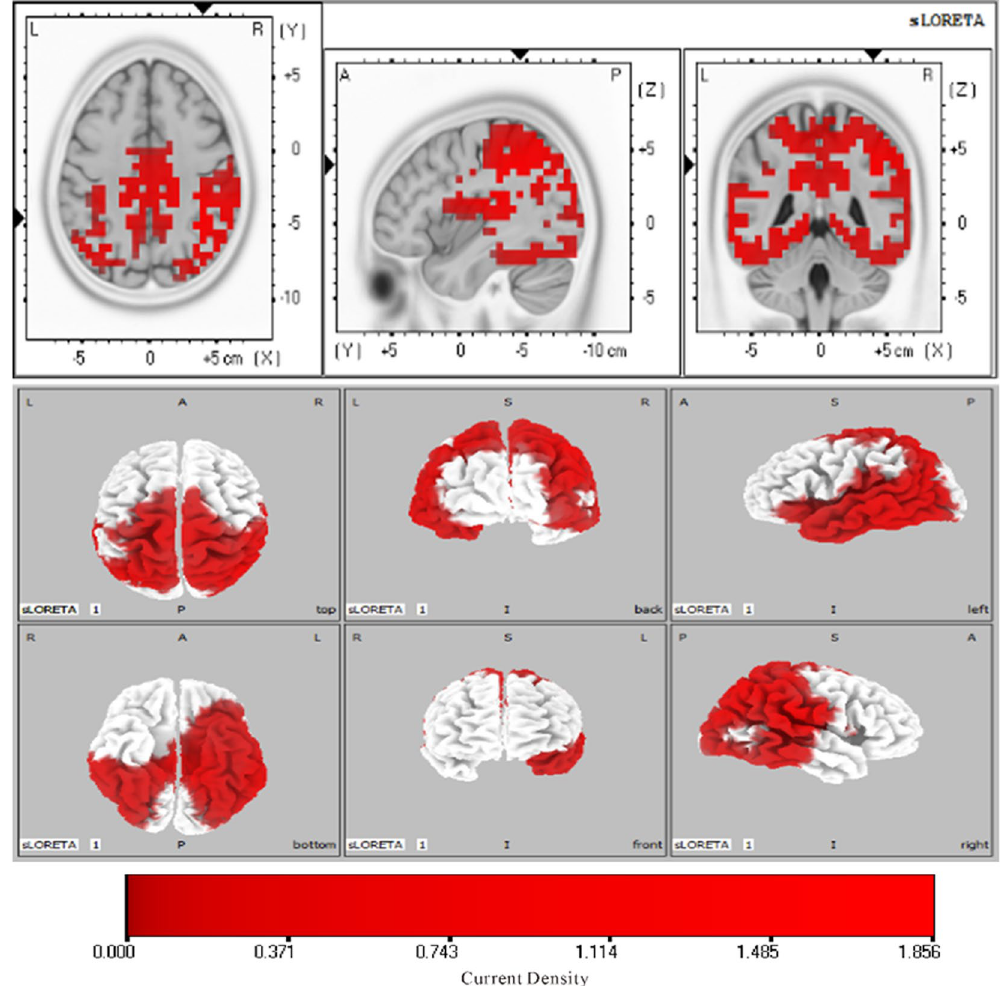
Figure 4. sLORETA images for the integration effect of multisensory WM over a timeframe of 236–530 ms (slice view and 3D view). The highest level of activation was localized in the inferior parietal lobule (BA